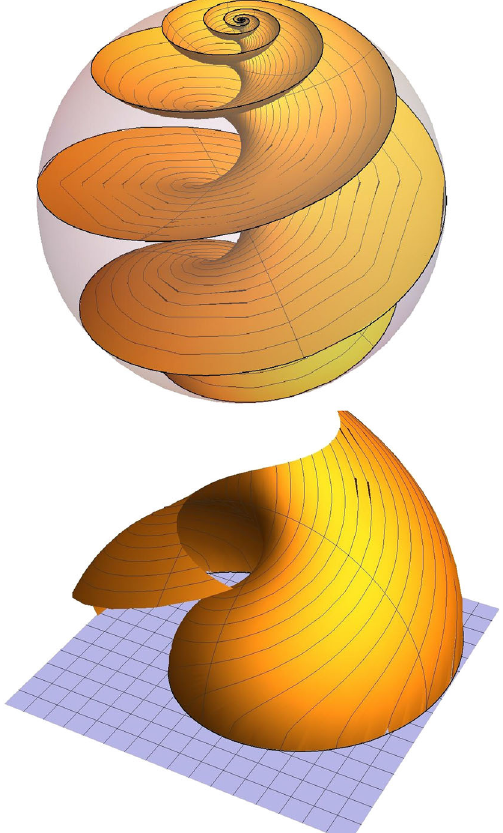
The helicoid minimal surface in both sets of coordinates is depicted in Fig.